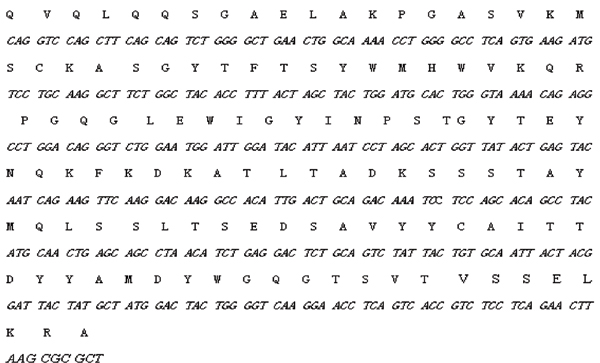
The sequence of the VH region of CSA.